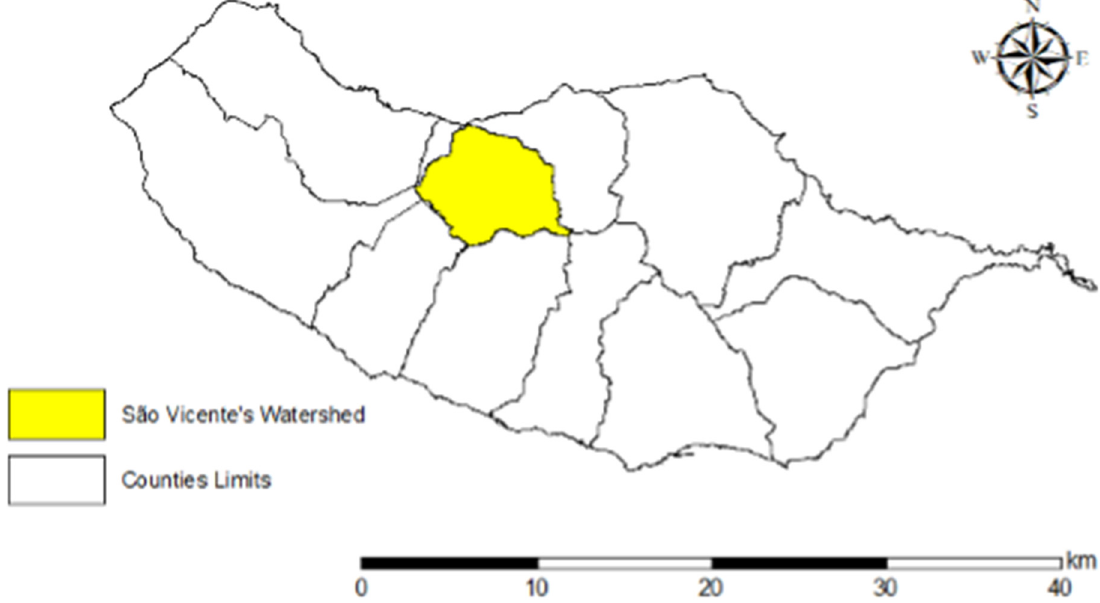
Figure 1. The S ã o Vicente watershed. (Source: Authors by ESRI ArcGIS, Figure 1. The São Vicente watershed. (Source: Authors by ESRI ArcGIS, 2020).